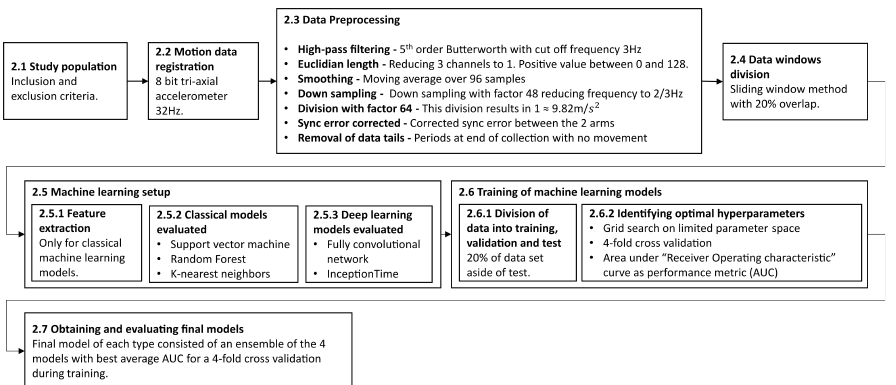
Figure 1. The outline of the methodology described in this study. It begins with the inclusion of patients and registration of data and describes the data preprocessing conducted, the machine learning setup and training, and finally the evaluation of the final models. Each step is described in more detail in the corresponding